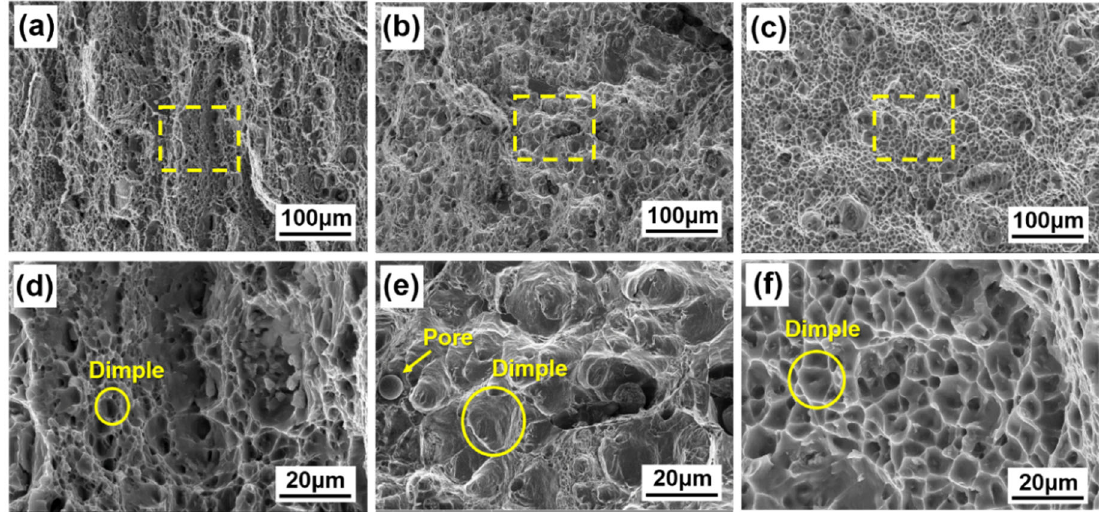
Figure 14. The fractured surface of different Al alloy joints: ( a ) and ( d ) for 5083; ( b ) and ( e ) for 6005A; ( c ) and ( f ) for 7N01.